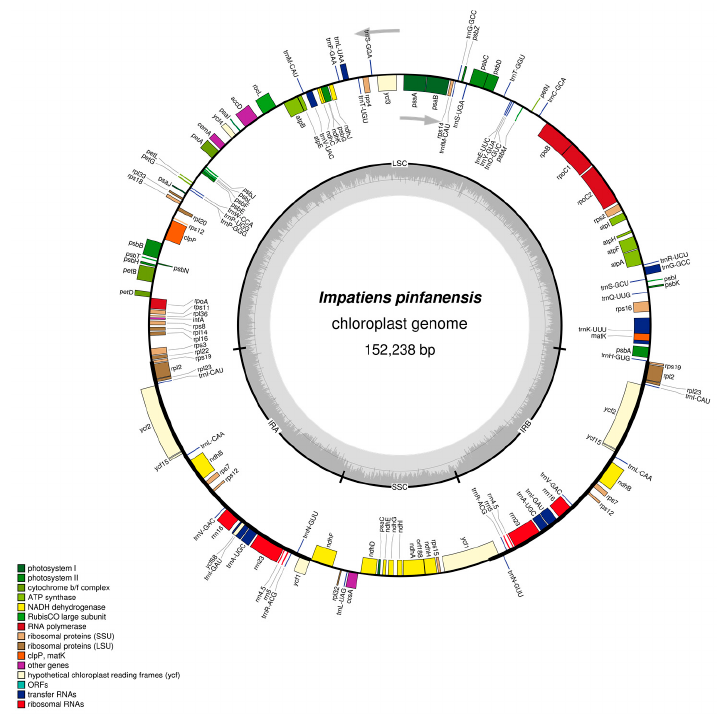
Figure 1. Gene map of the Impatiens pinfanensis chloroplast genome. Genes lying outside of the circle are transcribed clockwise, while genes inside the circle are transcribed counterclockwise. The colored bars indicate different functional groups. The dark gray area in the inner circle corresponds to GC content while the light gray corresponds to the adenine-thymine (AT) content of the genome.